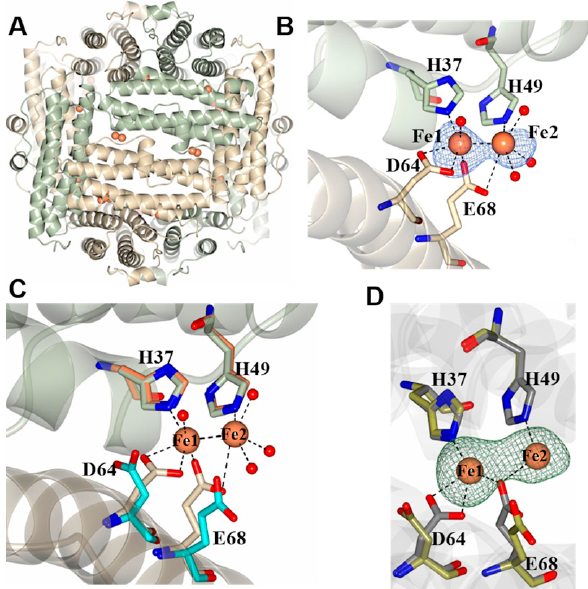
Figure 3. Iron binding sites in Dps: ( A ) View of the two identical di-iron binding sites that are present at the interface of subunit dimers in Dps-c-Fe; the iron ions are rendered as orange spheres, and the subunits in each subunit dimer as green and gray ribbons. ( B ) Expanded view illustrating the coordination of the iron ions at a di-iron site. The phased anomalous difference map (blue mesh) is contoured at 3 σ , and the water molecules are rendered as red spheres. ( C ) Superposition of apo- and Fe-bound Pa Dps-c structures; Pa Dps-c (orange/cyan) and Pa Dps-c-Fe (wheat/green). ( D ) Superposition of apo- and Fe-bound Pa Dps-o structures; Pa Dps-o (green) and Pa Dps-o-Fe (gray). The superpositions illustrate the conformational changes incurred upon iron binding. The green mesh in panel ( D ) is the Fo-Fc difference electron density map contoured at 3 σ . The Dps-c-Fe structure also showed patches of anomalous difference density and